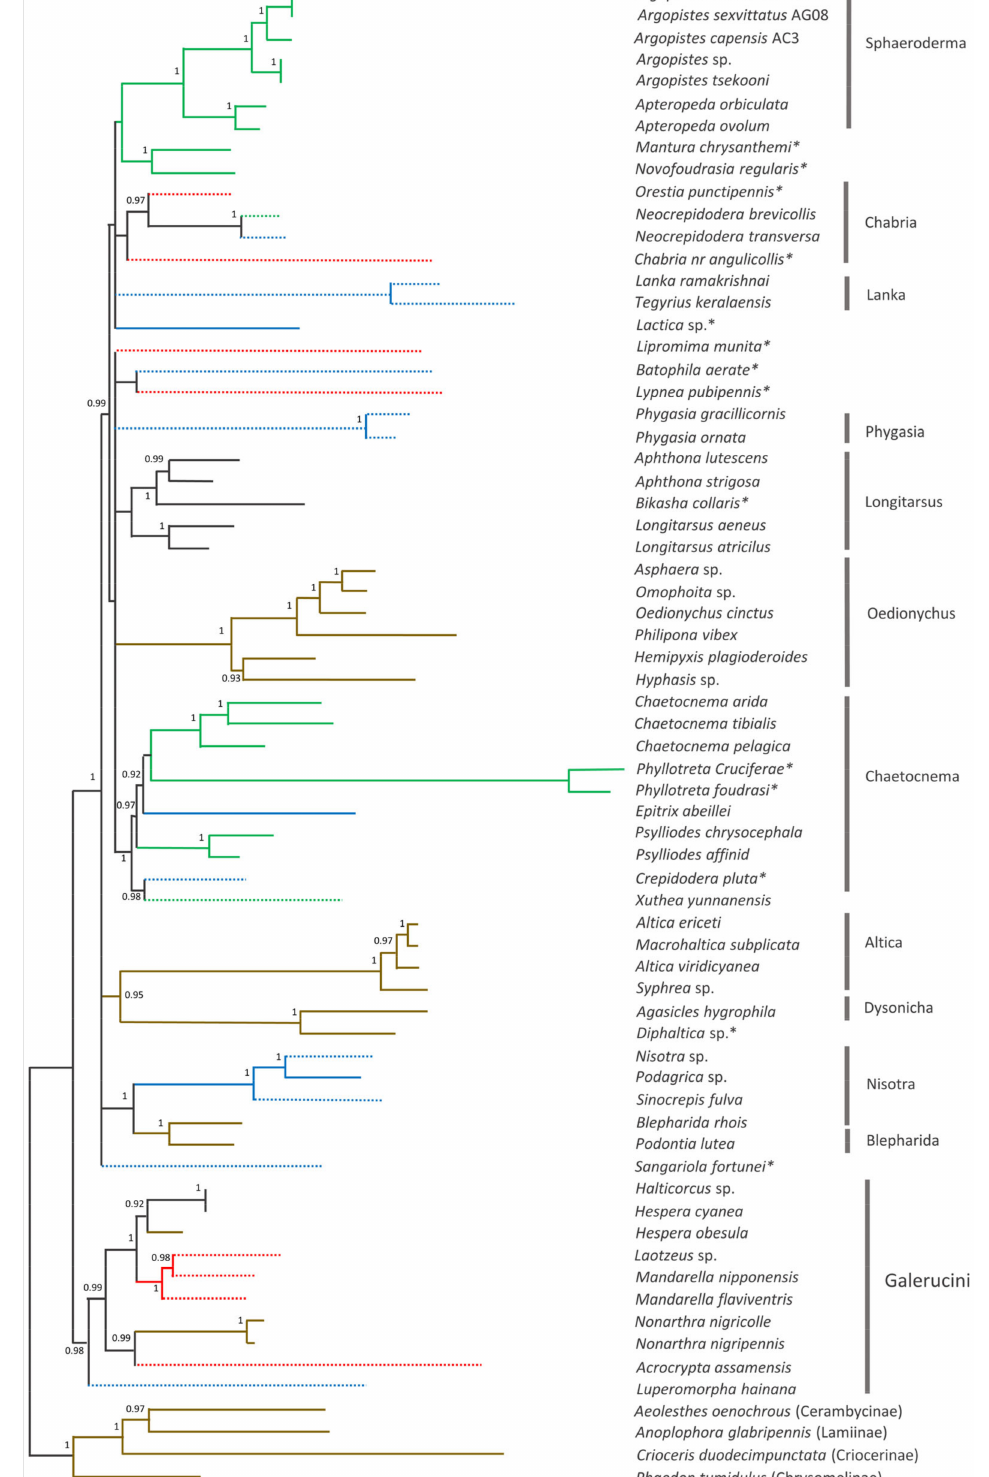
Figure 9. PhyloBayes tree of 64 Alticini species based on 13 mitochondrial protein-coding genes. Nodal support is given as Bayesian Posterior Probability; only values > 0.90 are shown. Branch colours represent larval feeding habits: leaf miner—green; external leaf feeder—brown; root feeder— blue; unknown—red. Dashed branches represent possible/unconfirmed/unclear larval feeding habits. * Genus group